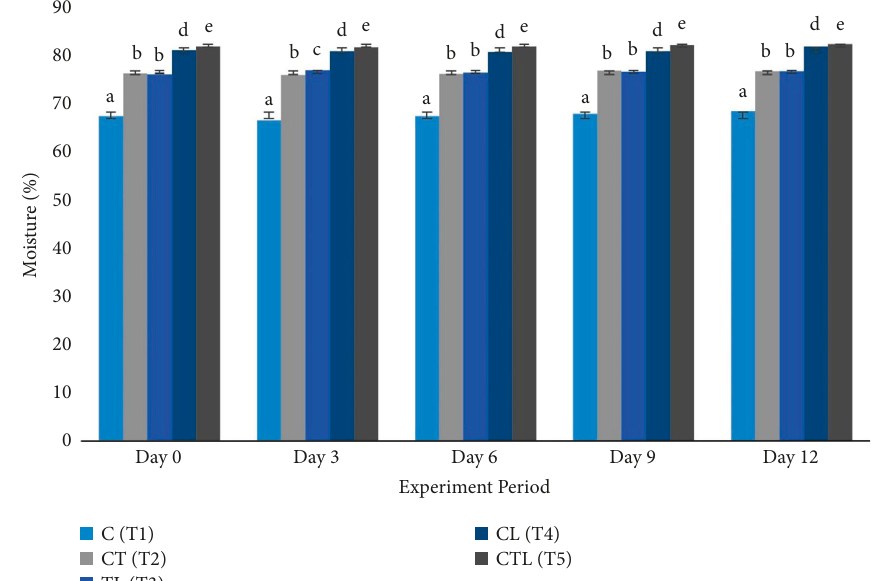
Figure 1: Percentage of moisture content in the carp fillet immersed in mixed different extracts of turmeric, cinnamon, and lemon at 4 °